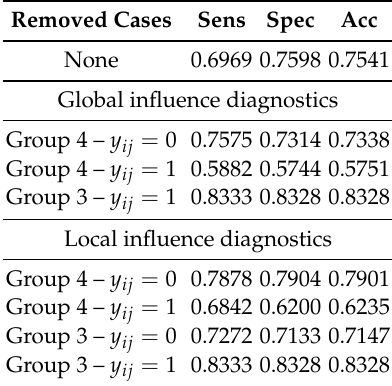
Table 9. Sens, Spec and Acc measures with Sens = Spec under the indicated influence for asthma